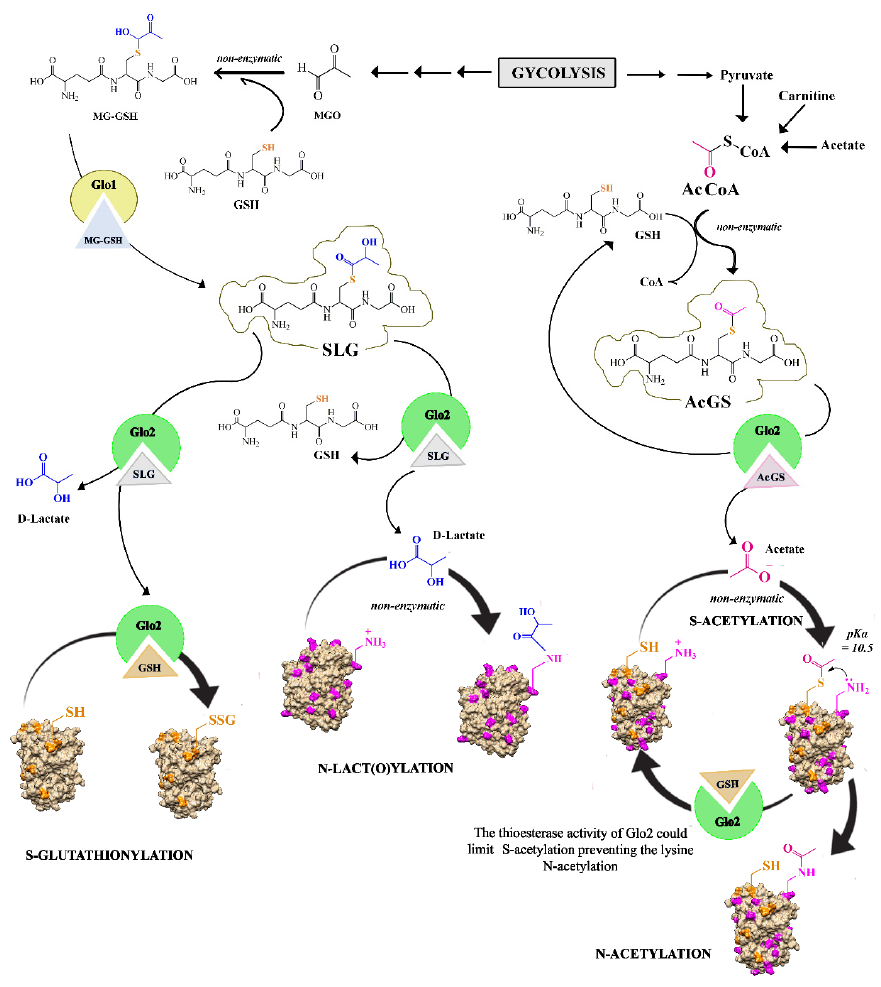
Figure 5. PTMs of lysine and cysteine residues involving Glo2. Glo1 converts 2-hydroxyacylglutathione (MG-GSH) into the thioester product S -D-lactoylglutathione (SLG). In S -glutathionylation, Glo2 catalyzes the hydrolysis of SLG, releasing D-lactate and transferring GSH in the GS* form from its active site to the cysteine residues of redox-sensitive target proteins. In N- lact(o)ylation, the acyl group of the D-lactate is transferred non-enzymatically to the lysine residues of target proteins, generating a lactoyl-lys modification. Acetyl coenzyme A (AcCoA) and S -acetylglutathione (AcGS) reversibly acetylate protein cysteine residues ( S -acetylation) followed by transfer of the acetyl moiety to a nearby lysine on mitochondrial proteins ( N -acetylation). The thioesterase activity of Glo2 could limit S -acetylation and therefore the lysine N -acetylation. Glo2 catalyzes the hydrolysis of SLG, forming D-lactate and releasing glutathione. The energy released by this process is comparable to that released in the cleavage of an ATP molecule to ADP, so it was necessary to ask where this energy converged during the hydrolysis of SLG. In 2004, our research group hypothesized that Glo2 could play an ad- ditional role to that of a thiolesterase, using glutathione in the SLG form to specifically glutathionylate certain redox-sensitive proteins, thus paving the way for the hypothesis on the involvement of the glyoxalase system in post-translational regulatory modifica- tions of proteins. S -glutathionylation is a PTM that can regulate the activity of multiple redox-sensitive proteins, and its modifications are present in several oxidative stress-re- lated diseases [124–126].